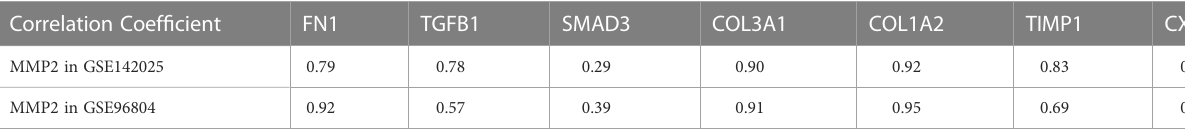
TABLE 2 Correlation analysis between MMP2 and common fi brosis